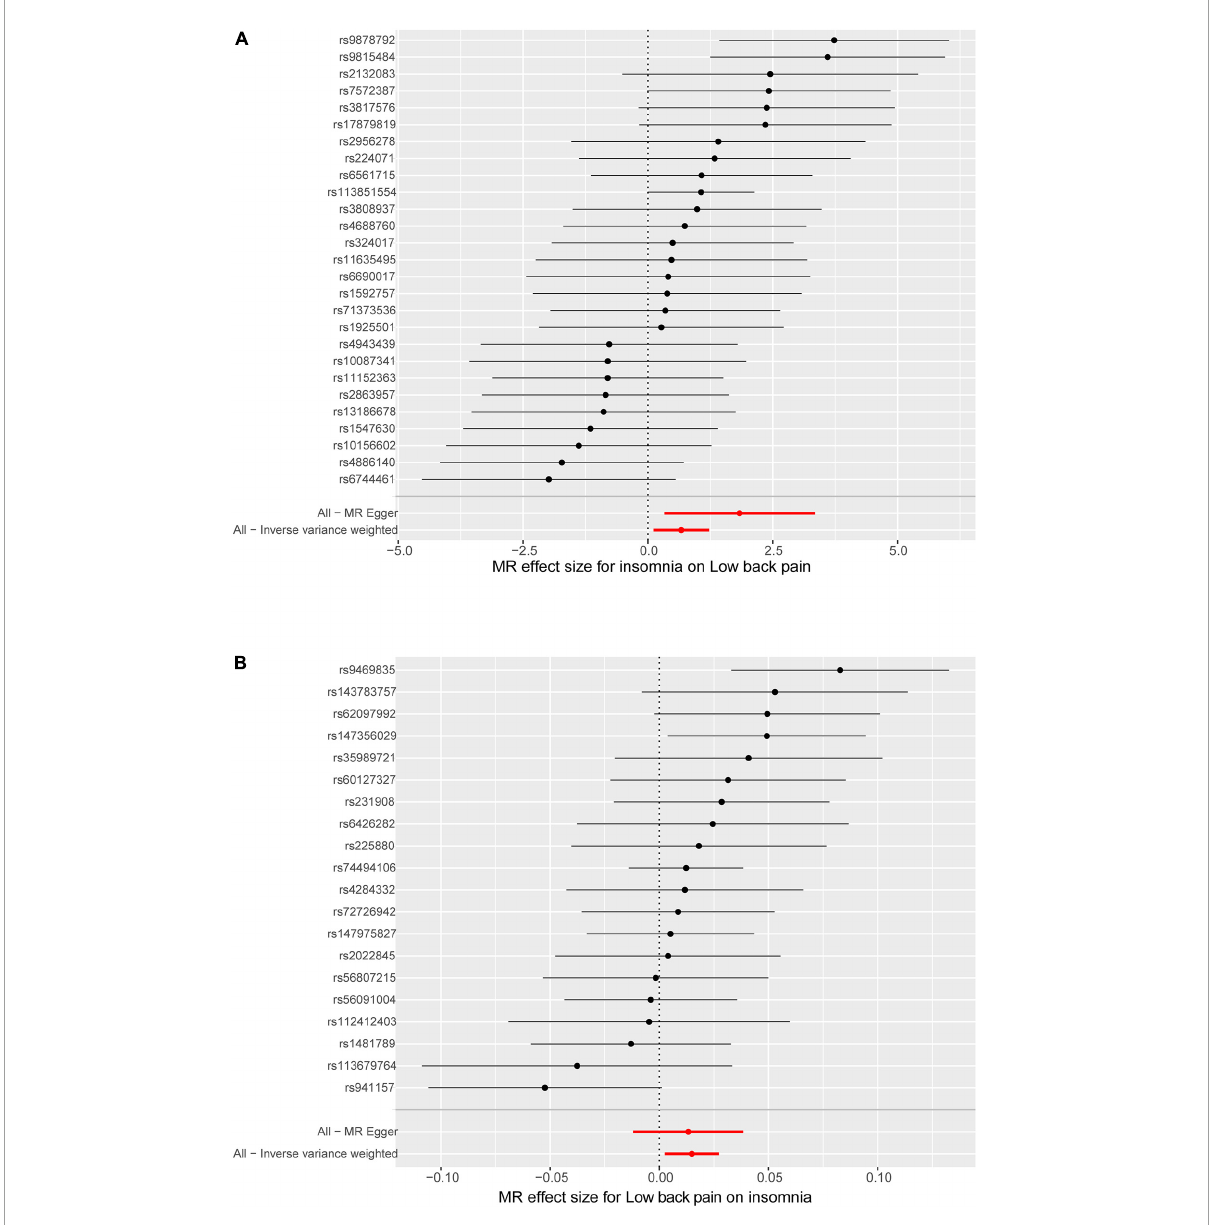
FIGURE2 Forest plot of the causal effects between sleep disturbance and low back pain. In (A) , the x -axis shows that the MR effect size for insomnia on low back pain, and the y -axis shows the effect for each of the single nucleotide polymorphisms (SNPs); (B) shows the results of the reverse causal inference. MR Egger and inverse variance weighted (IVW) analyze the total effect of the genetic variants (or exposure) on the outcome.